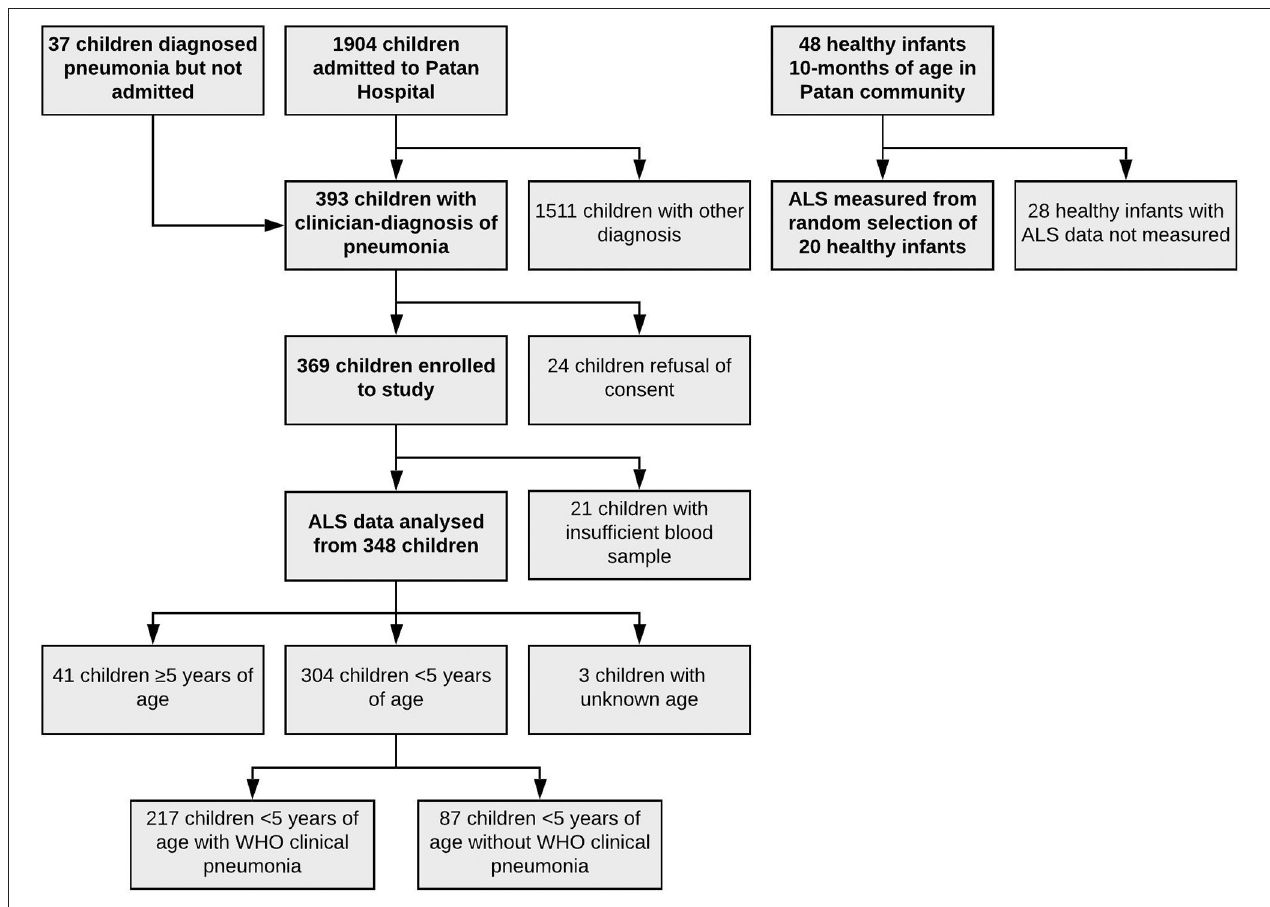
FIGURE 2 | Flow diagram of enrolment to the